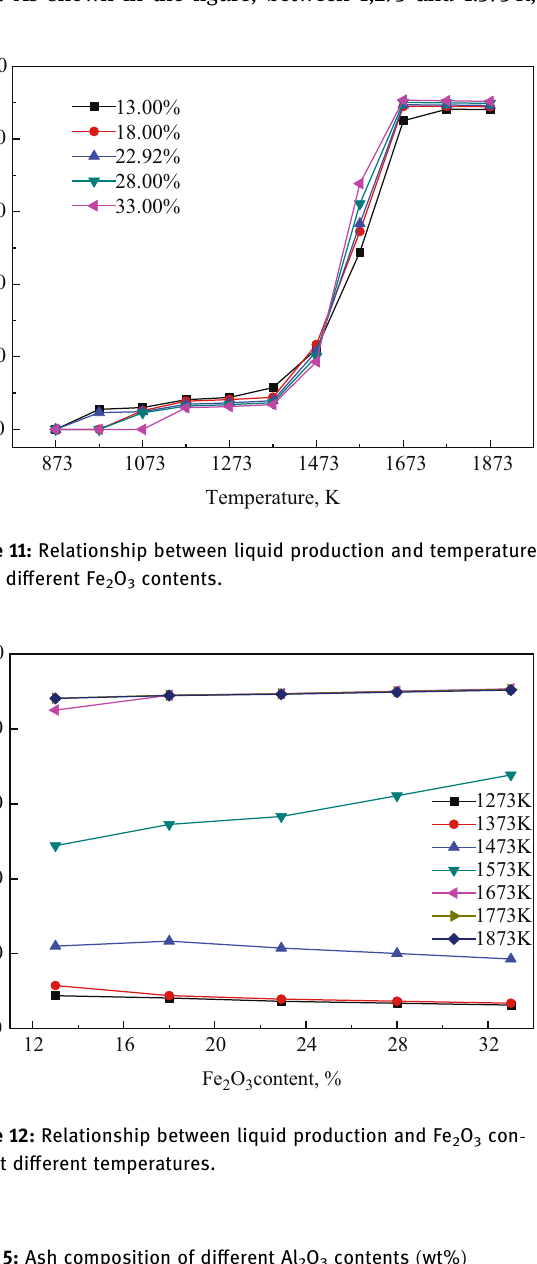
Table 5: Ash composition of di ff erent Al 2 O 3 contents ( wt% )